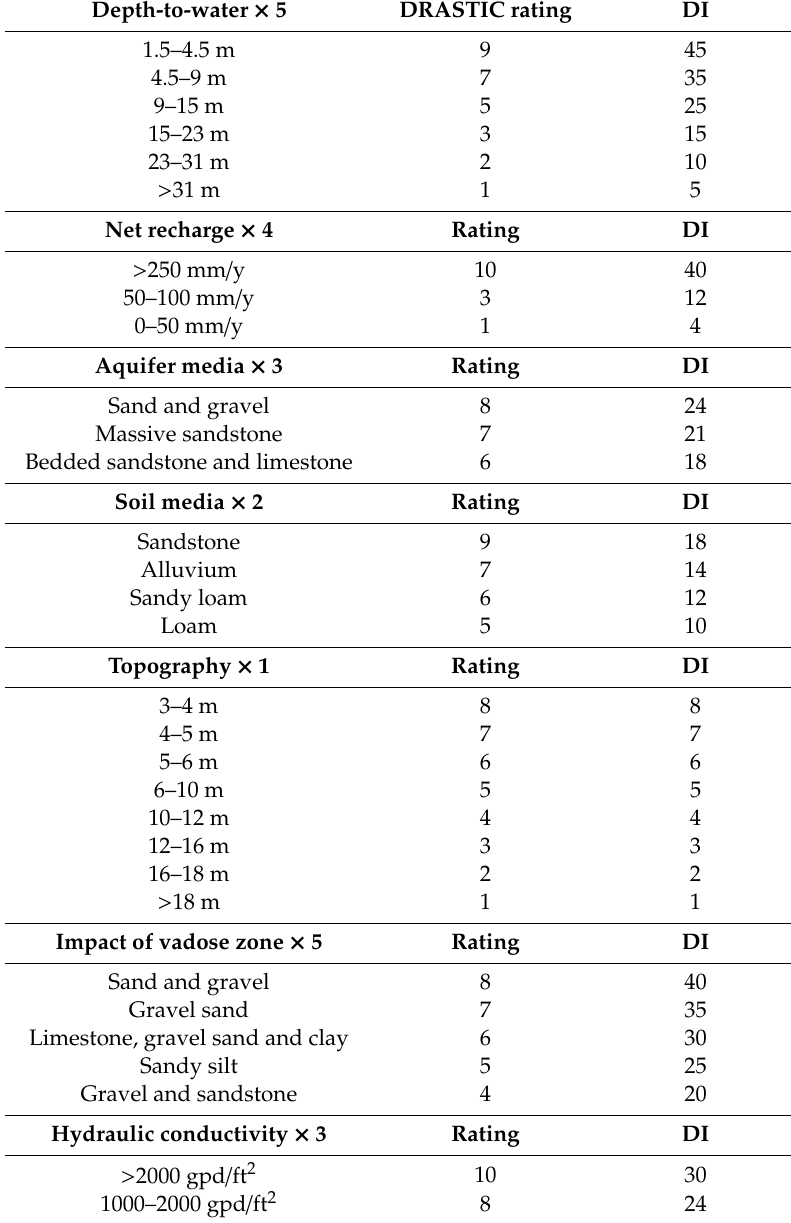
Table 2. Dahomey Basin DRASTIC parameters and DRASTIC Index